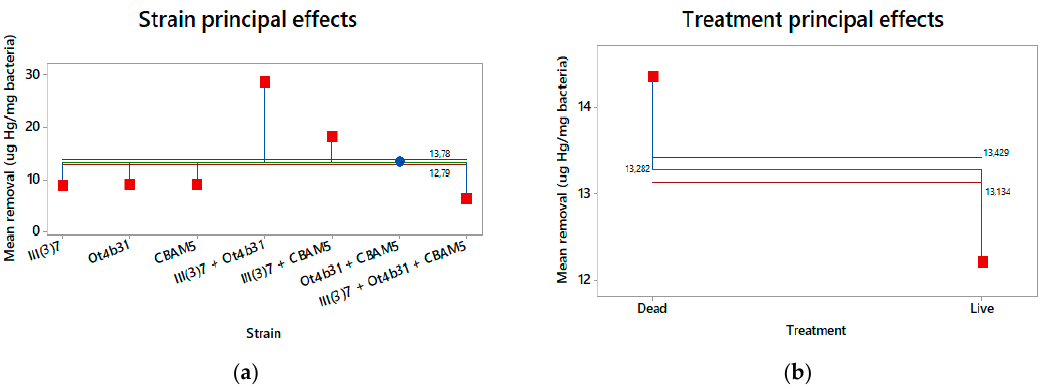
Figure 3. ANOM graphs of principal effects on mercury removal by L. sphaericus. ( a ) Effect of bacteria Figure 6. ANOM graphs of principal e ff ects on mercury removal by L. sphaericus. ( a ) E ff ect of bacteria strain (alone or mixed); ( b ) Effect of bacteria treatment (dead or live). strain (alone or mixed); ( b ) E ff ect of bacteria treatment (dead or